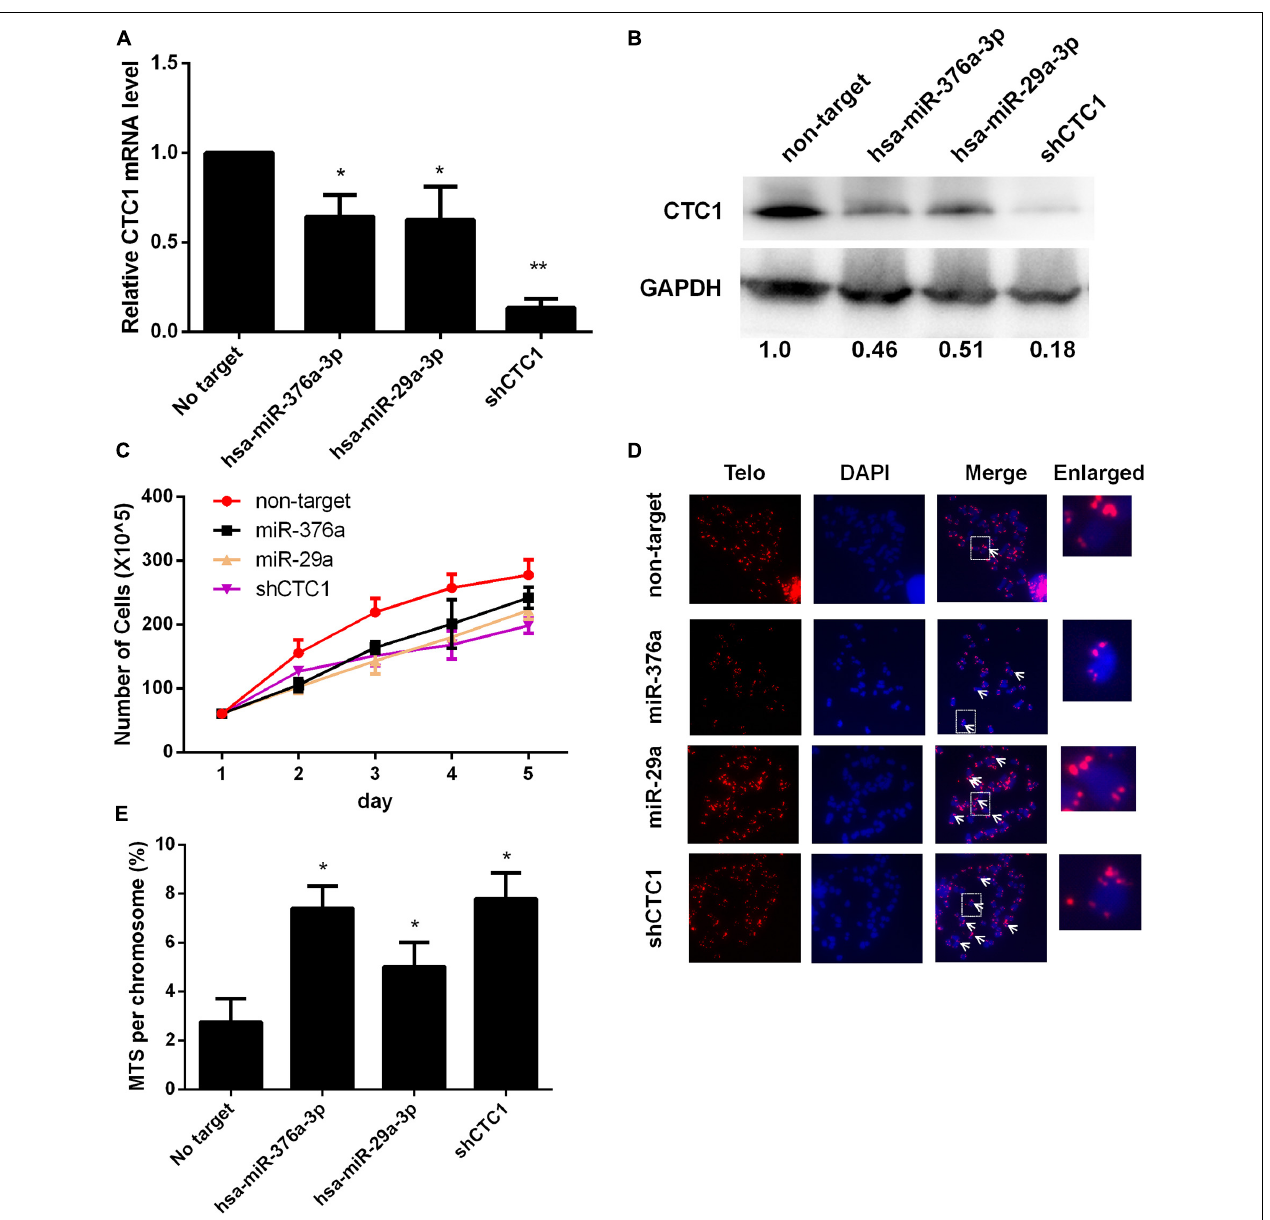
FIGURE 2 | Selected microRNAs (miRNAs) could induce telomere dysfunction via downregulating CTC1 expression. (A) The relative CTC1 messenger RNA (mRNA) transcriptional level was determined by quantitative real-time PCR in the control and the miRNA or short hairpin RNA (shRNA) treatment groups. The expression difference was calculated by one-way ANOVA, with * P < 0.05 and ** P < 0.01. (B) The protein level was evaluated by Western blot assay upon miRNA or shRNA treatment. The relative gray value was annotated below each panel . (C) The growth curve upon miRNA or shRNA treatment was determined by cell counting. (D) Representative images of metaphase telomere fluorescence in situ hybridization (FISH) upon different treatments. Multi-telomeric signal (MTS) is indicated by the white arrows . The red florescence exhibits telomere FISH signal while chromosomes were stained with DAPI ( blue ). (E) The percentage of chromosomes with MTS was calculated upon miRNA or shRNA treatment based on the FISH results as demonstrated in panel (D) . Statistical analysis was calculated by one-way ANOVA, with * P <